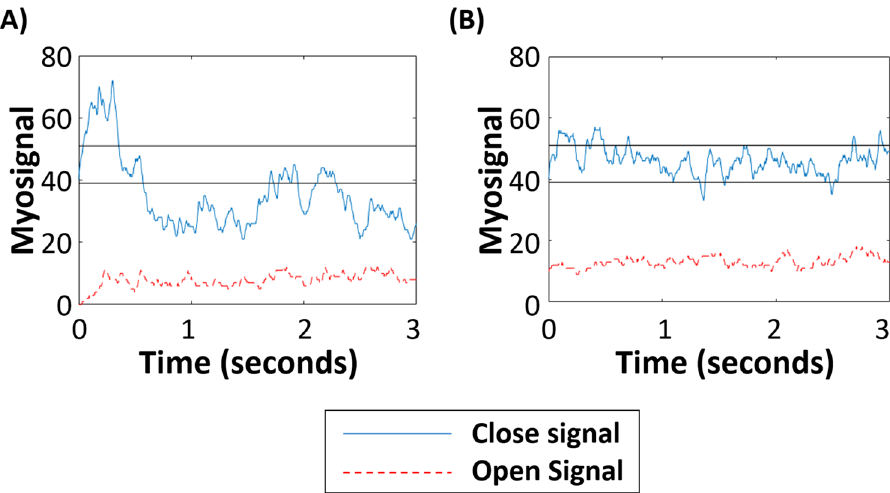
Figure 8. Static Tracking Task closing trial example for the ( A ) worst (22%) and ( B ) best (85%) performers. Participants were instructed to keep the blue signal (controlled using the muscle for hand closing) inside the boundary lines, whilst keeping the other muscle (red dotted) relaxed. The trial lasted 3